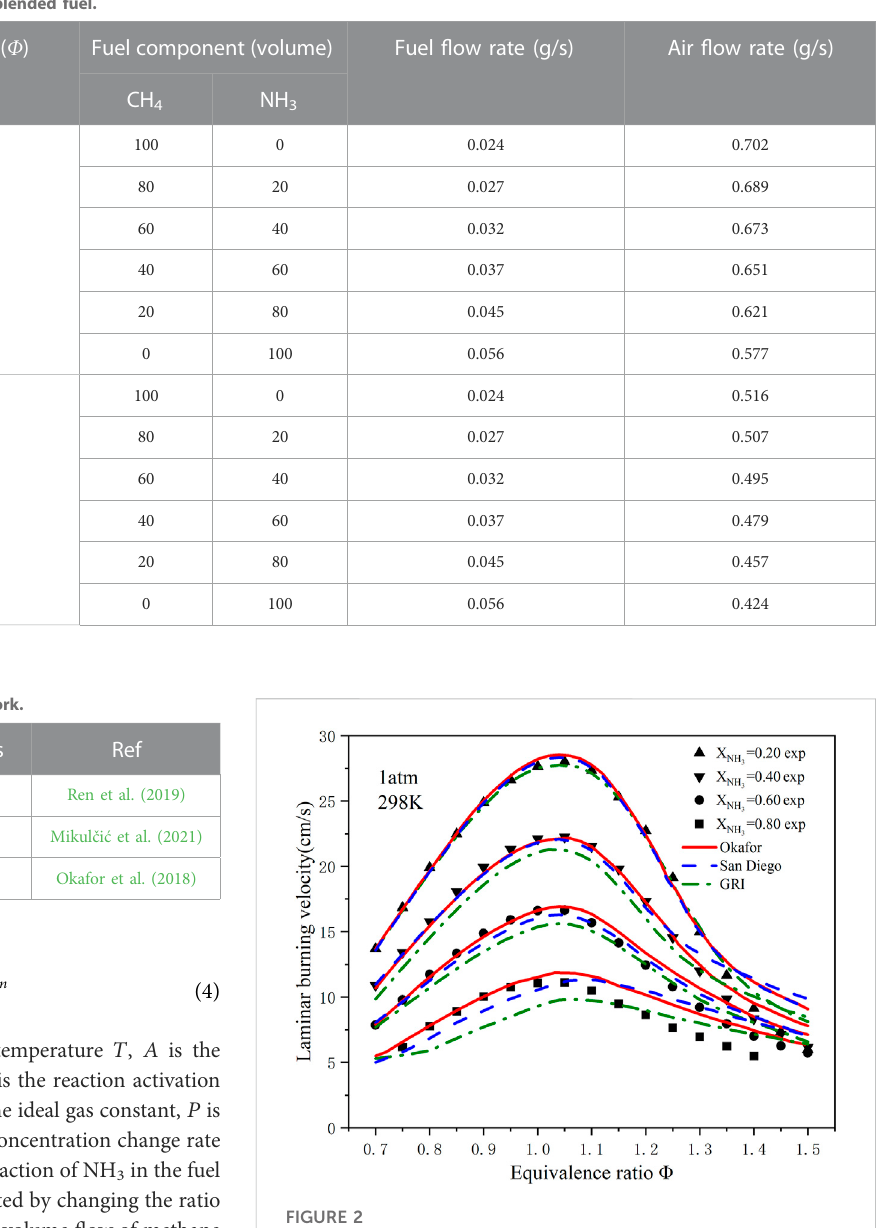
TABLE 1 Flame conditions for ammonia/methane blended fuel.